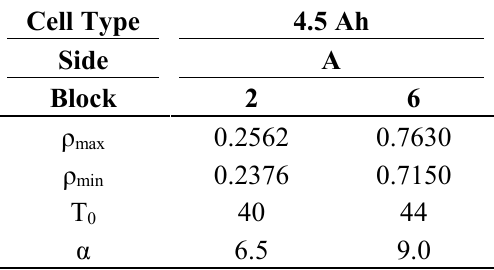
Table 4. Fitted parameters of representative blocks of side A on 4.5 Ah